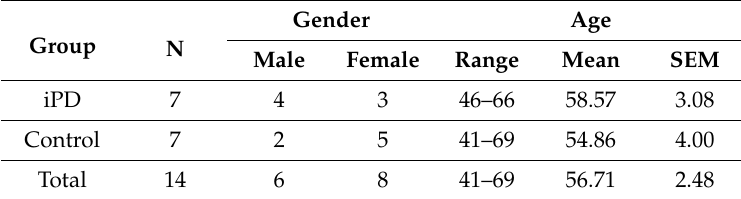
Table 1. Epidemiological characteristics of patients and controls included in the study. SEM, standard error of the